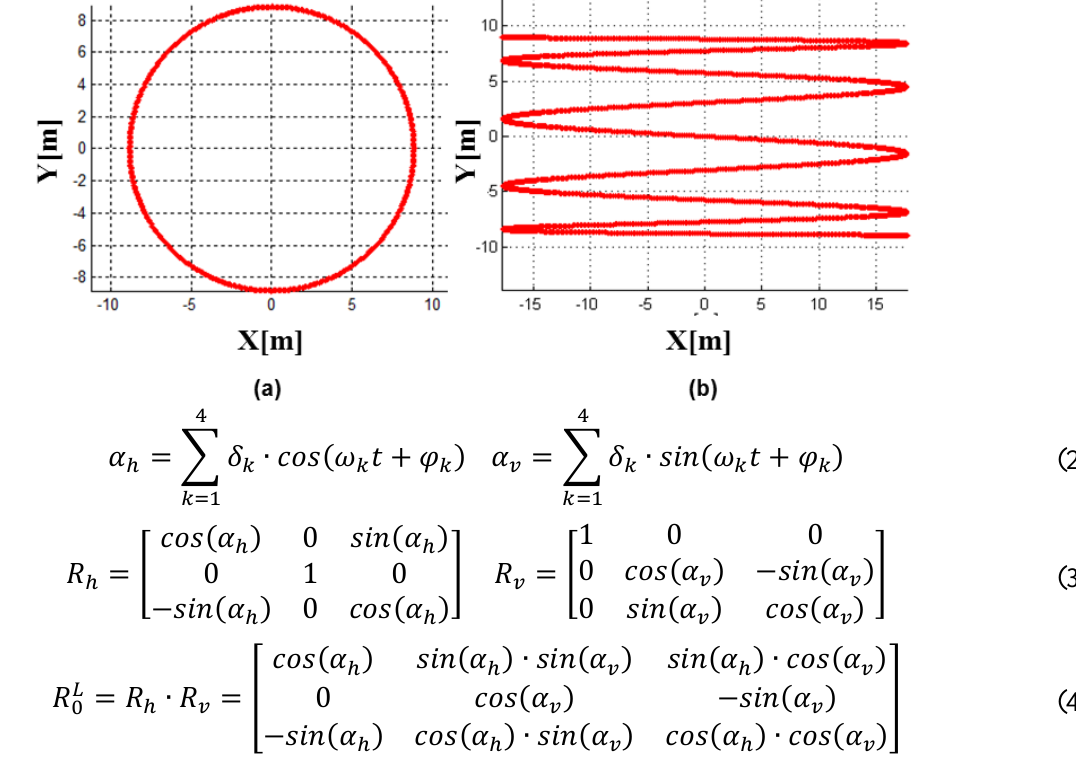
Figure 6. Scan pattern by the wedge prisms with deflection angle of 0.256° at 1 km ( a ) and pattern using two pairs of counter-rotating optical wedge prisms with the horizontal deflection angle of 0.506° and the vertical deflection angle of 0.506° at 1 km ( b ). Combination of two wedge prisms makes it possible to implement the reciprocating pattern, which is parallel to the vertical or horizontal